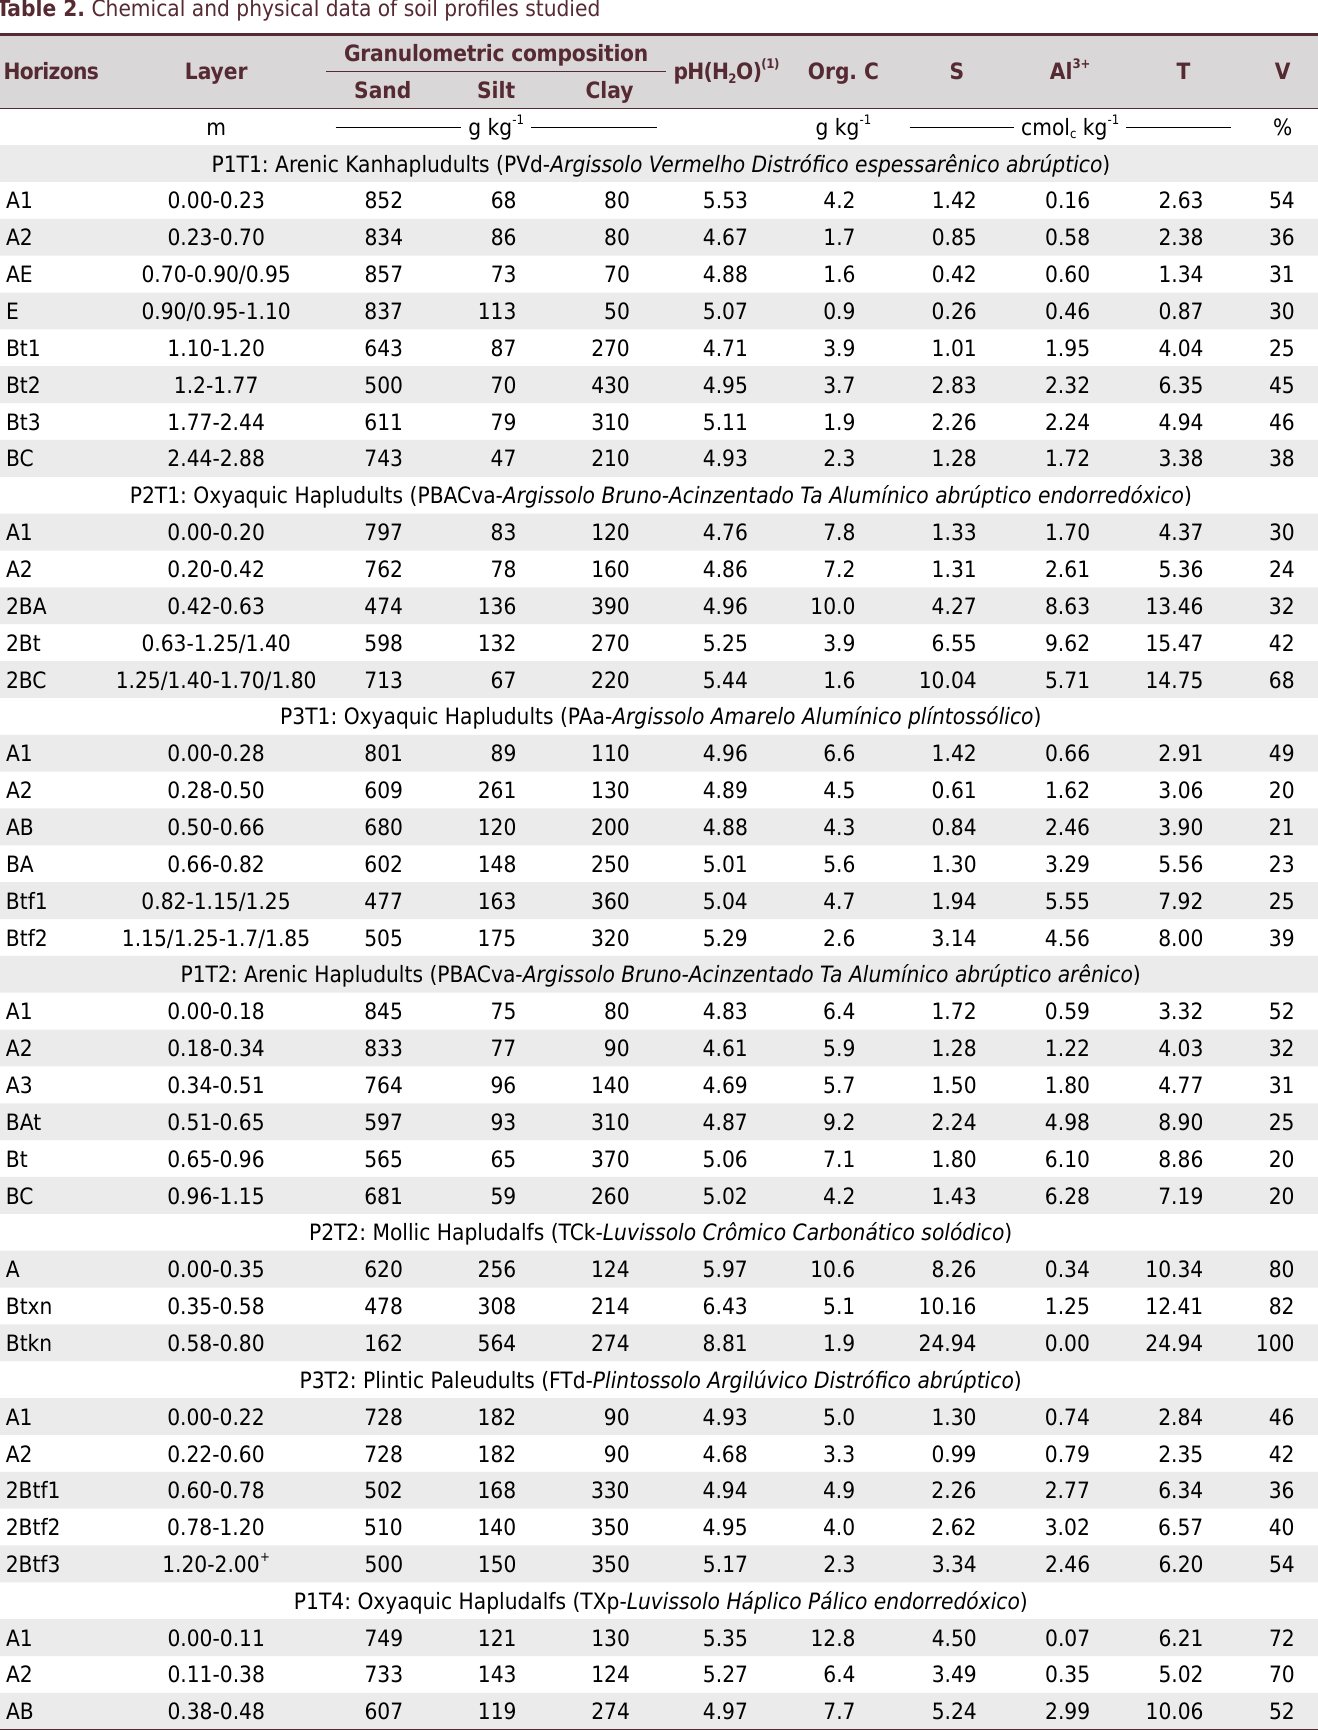
Table 2. Chemical and physical data of soil profiles studied Granulometric composition Horizons Layer pH(H 2 O) (1) Org. C S Al 3+ T V Sand Silt Clay g kg -1 g kg